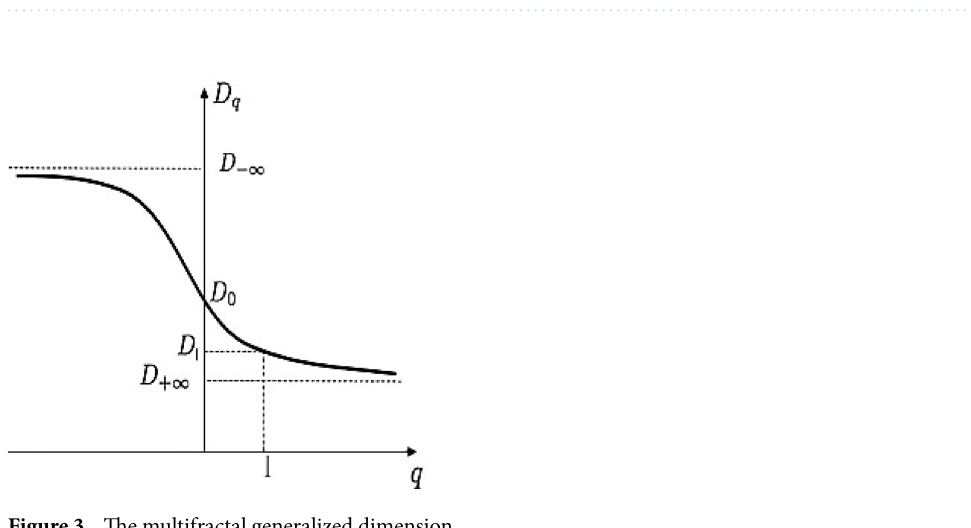
Figure 3. The multifractal generalized